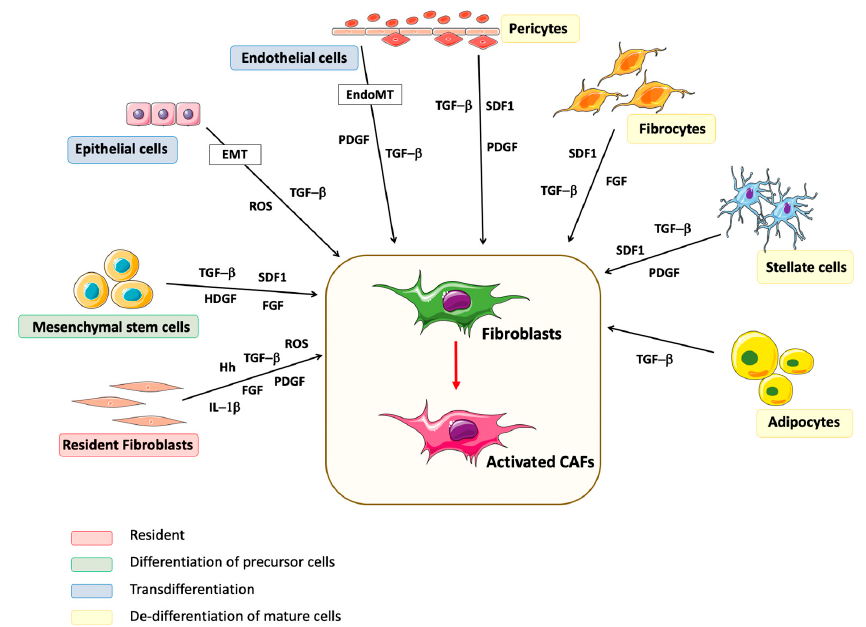
Figure 1. Origin of Cancer-Associated Fibroblasts. The di ff erent cellular sources for CAFs are shown, colors indicate the type of origin. Factors involved in the recruitment, di ff erentiation and activation of these cells into CAFs are indicated for each cell